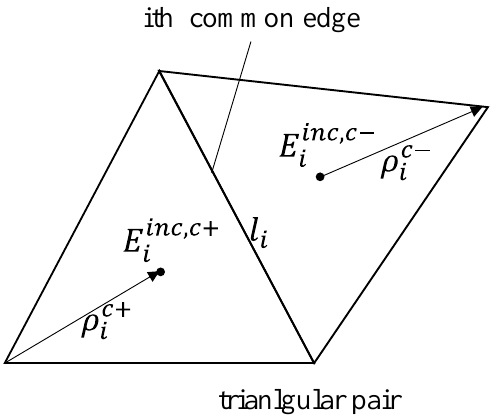
Figure 7. The division of the MLFMA and BT regions for the whole